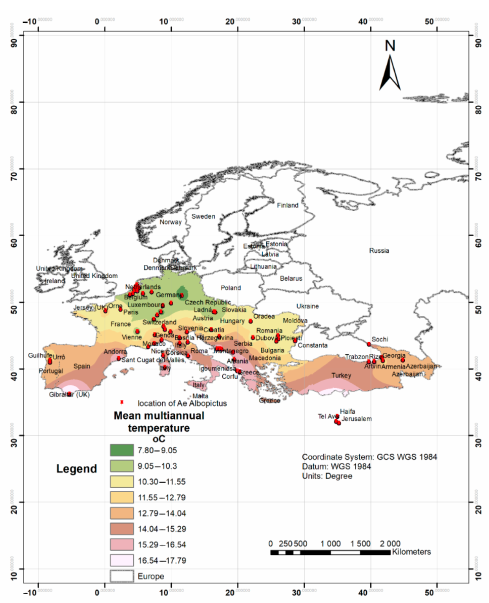
Figure 4. The mean multiannual temperatures in the geographical area where the Ae. albopictus was